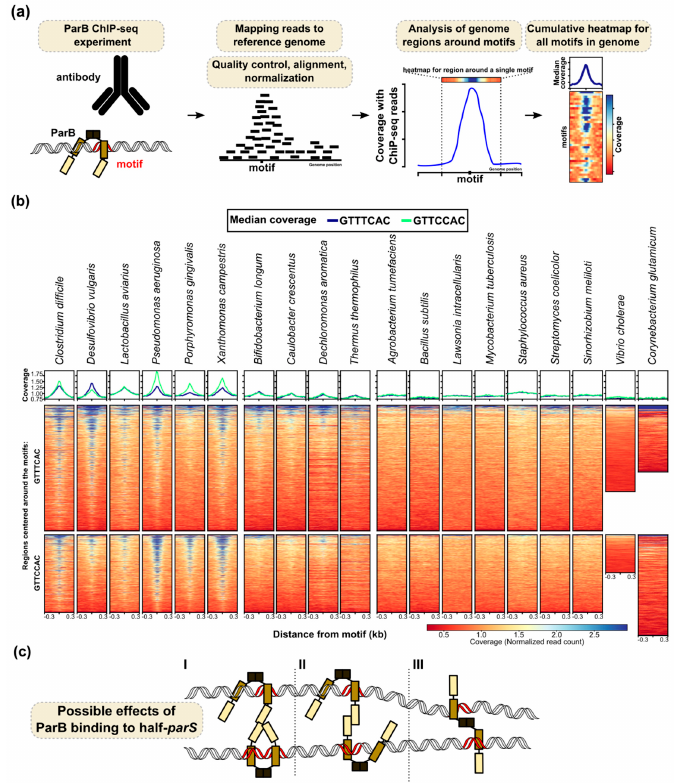
Figure 3. Interactions of ParBs with half- parS sites. ( a ) Outline of the analysis of ParB binding to half- parS using the available ParB ChIP-seq data. ( b ) The binding of ParB proteins from various bacterial species to half- parS s assessed by the enrichment of half- parS (GTTCCAC and GTTTCAC) containing genomic DNA fragments in the ChIP samples. Heatmaps represent the read coverage for the ParB ChIP samples, calculated for each nucleotide of a ± 300 bp region around all the indicated motifs in the corresponding reference genomes. Plots represent median coverage. A central increase of the coverage indicates enrichment of the DNA containing motif during chromatin immunoprecipitation for the corresponding ParB protein; hence, ParB binds to these sequences. The ChIP-seq data for 17 ParBs from di ff erent species produced in E . coli [Gene Expression Omnibus GSE129285 [142]], V . cholerae ParB1 [GSM3161909, GSM3161911 [129]], and C . glutamicum ParB [SRX5581454, SRX5581458, SRX5581460 [72]] were included in the analysis. Raw data were downloaded from the sequence read archive (SRA) and quality-controlled using fastp [143]. Reads were mapped to the reference genomes of E . coli K-12 substr. MG1655 (U00096.3), V. cholerae O1 biovar El Tor str. N16961 (only chrI, NC_002505.1), and C. glutamicum ATCC 13032 (BX927147), respectively, using Bowtie [144] with the –sensitive-local option. Samtools was used to exclude duplicate reads and sort the .bam files [145]. Coverage (.bigwig) files were generated with bamCoverage [146], using the –normalizeUsing RPGC option, without binning and smoothing. Half- parS motifs (GTTCCAC and GTTTCAC) were identified in the corresponding genomes using fuzznuc (Emboss 6.6.0). Heatmap displaying coverage with reads in the ParB ChIP data around the identified motifs were generated using plotHeatmap from deepTools [146]. Each line in the heatmap represents the normalized read counts for each nucleotide of a ± 300 bp region around one motif, sorted in the descending order of the mean coverage value and colored according to scale. The median coverage score for the two sets of motifs is presented on plots above the heatmap. For V . cholerae and C . glutamicum , the data from the biological replicates were averaged. ( c ) Hypothetical model engaging the half- parS sites in DNA structuring. I—The ParB complex loaded at parS interacts with an “open” dimeric ParB bound to a half- parS site. II—Interactions between two ParB dimers bound to separate half- parS s. III—Both monomers in a ParB dimer interact with separate half- parS s. All scenarios result in the formation of DNA bridges. In this model, we assume that the binding of ParB to half- parS involves the HTH in the central